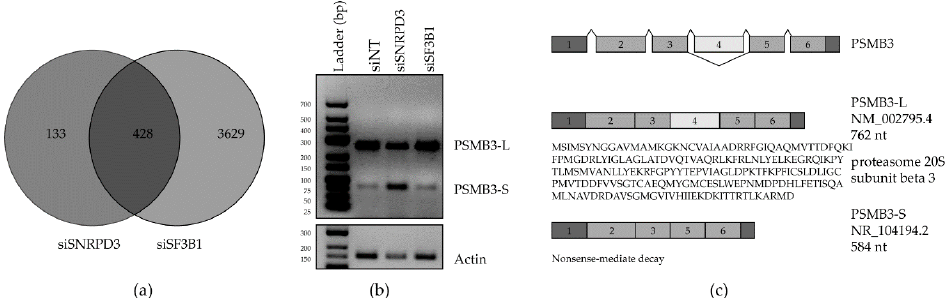
Figure 2. Identification and validation of alternative splicing (AS) events unique to the knockdown of SNRPD3 compared to SF3B1. ( a ) Venn diagram showing the overlap in AS events identified in siSF3B1- and siSNRPD3-treated cells. ( b ) AS of the proteasomal subunit beta 3 (PSMB3) was